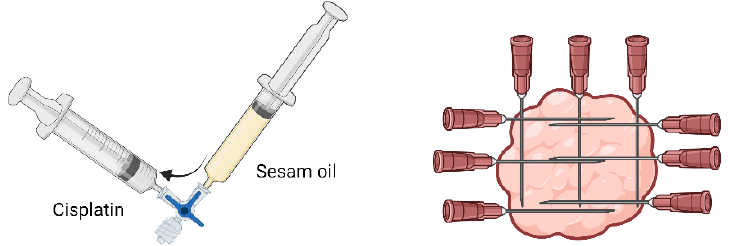
Figure 2. Cisplatin preparation and injection. The tumoral mass should be injected in multiple plans to ensure that cisplatin is equally distributed (created with